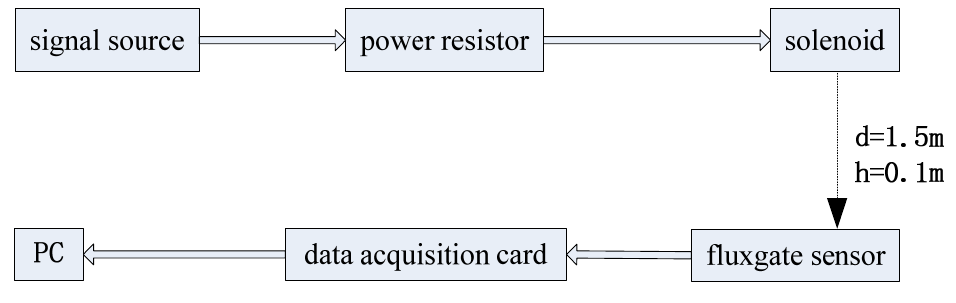
Figure 10. The structure of the experimental system.